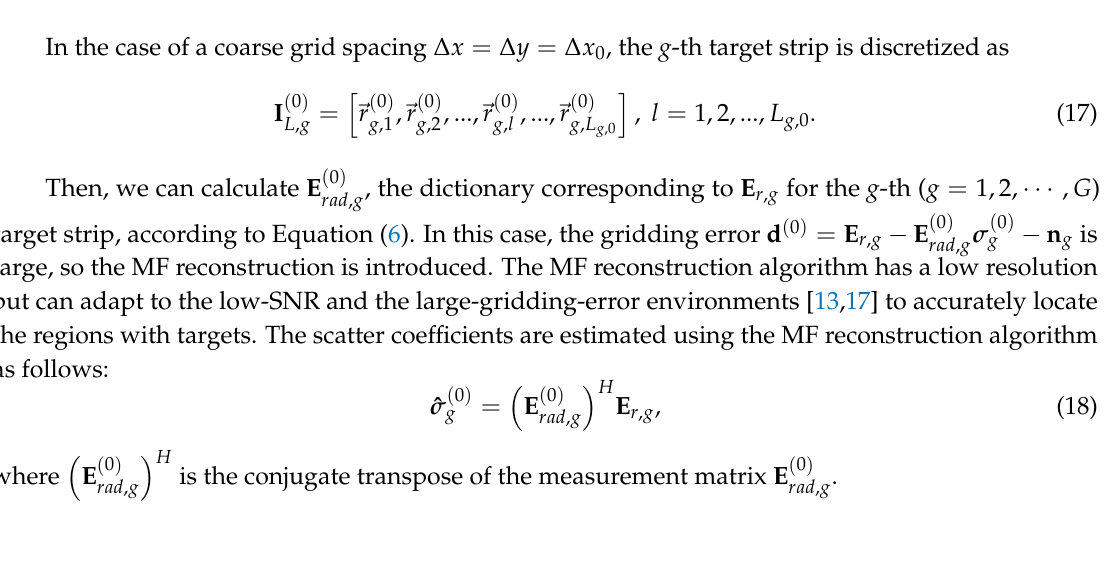
Figure 3. Coherence pattern. ( a ) three-dimensional view; and ( b ) plane